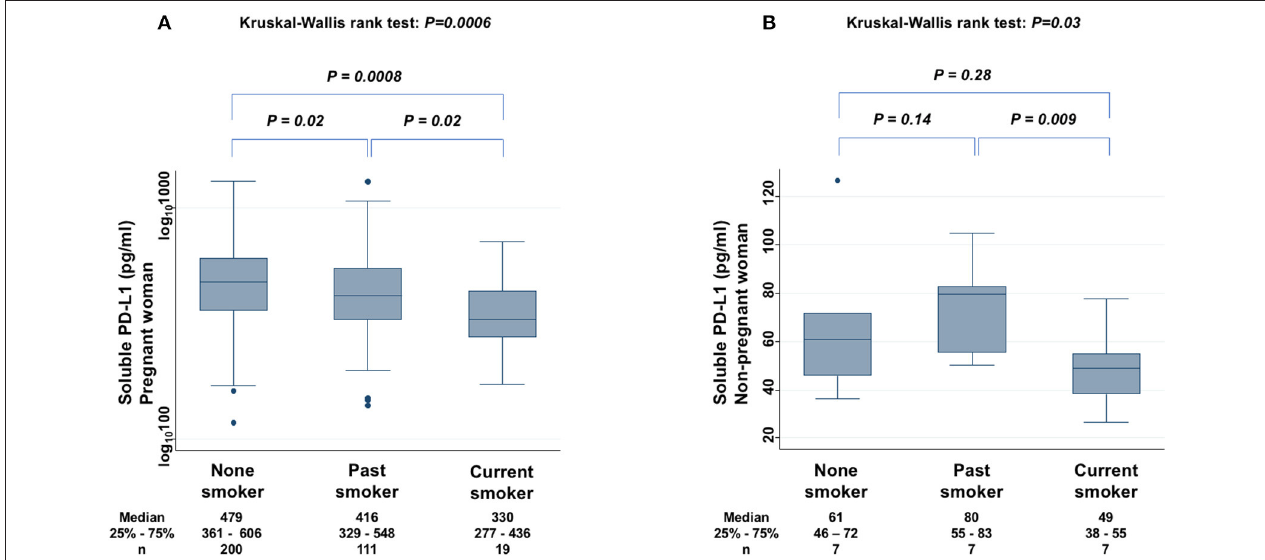
FIGURE 5 | Relationship between sPD-L1 levels and smoking status in PW (A) and in non-PW (B) . The Kruskal-Wallis rank test (KW test) was used for comparisons among three groups: non-smoker, past smoker, and current smoker. The Mann-Whitney test was used to compare two groups; sPD-L1 values were transformed by the common logarithm (log 10 ) prior to analysis and are shown in the graph (A) , although the median and 25 − 75th percentiles are presented as absolute values.